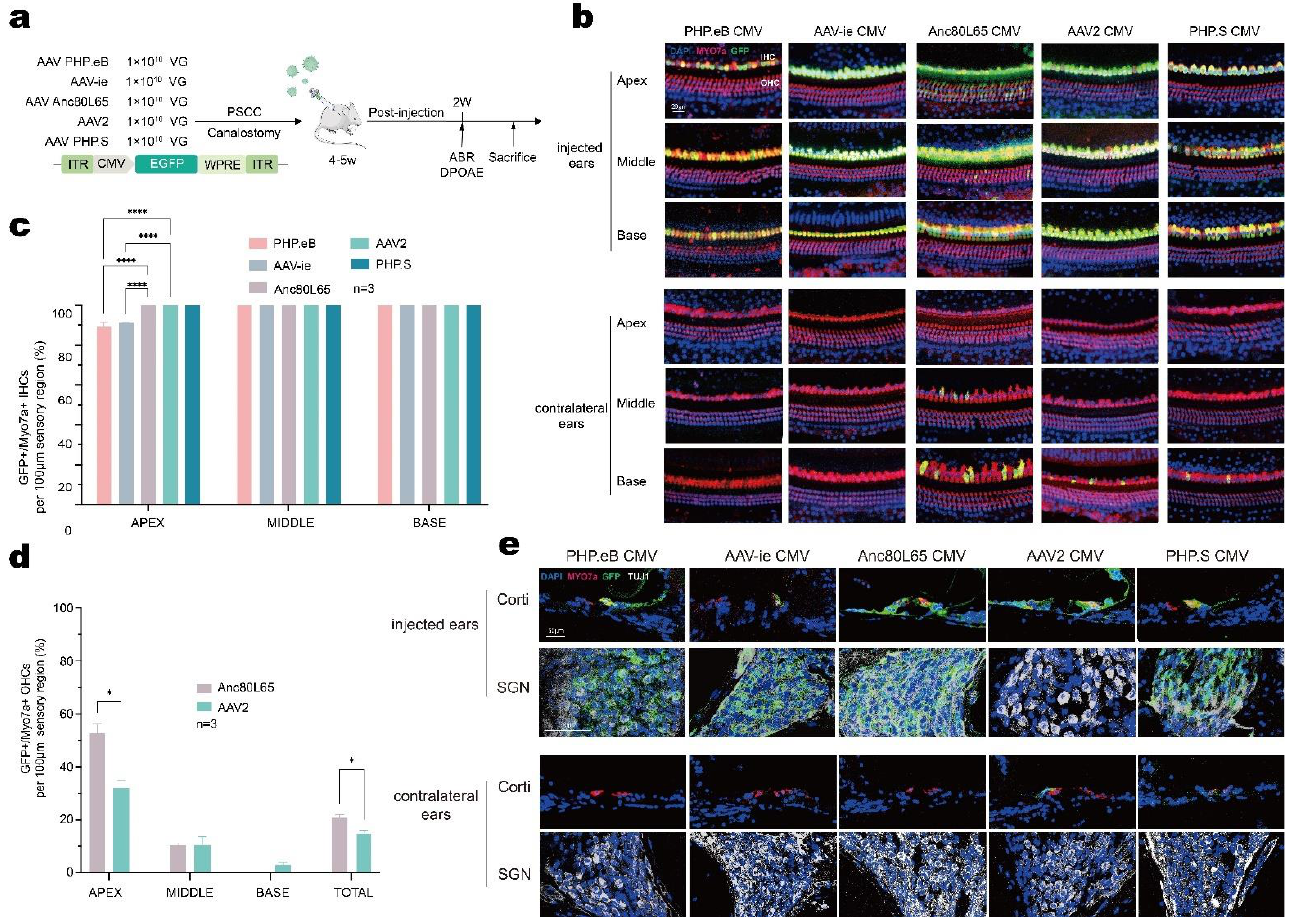
Figure 4. Frozen sagittal brain sections from AAV-Anc80L65-injected adult mice (4 – 6 weeks old) using different surgical approaches. Two weeks after the cochlear injection, brain tissues were rap- idly extracted. The whole sagittal brain section image at the top came from the t-RP group, and the high-magnification images were taken from the following brain regions of each group: the cerebral cortex (1 and 2), midbrain (3), cerebellum (4), and hindbrain (5). The cell nuclei were stained with DAPI (blue), and native eGFP was imaged (green).